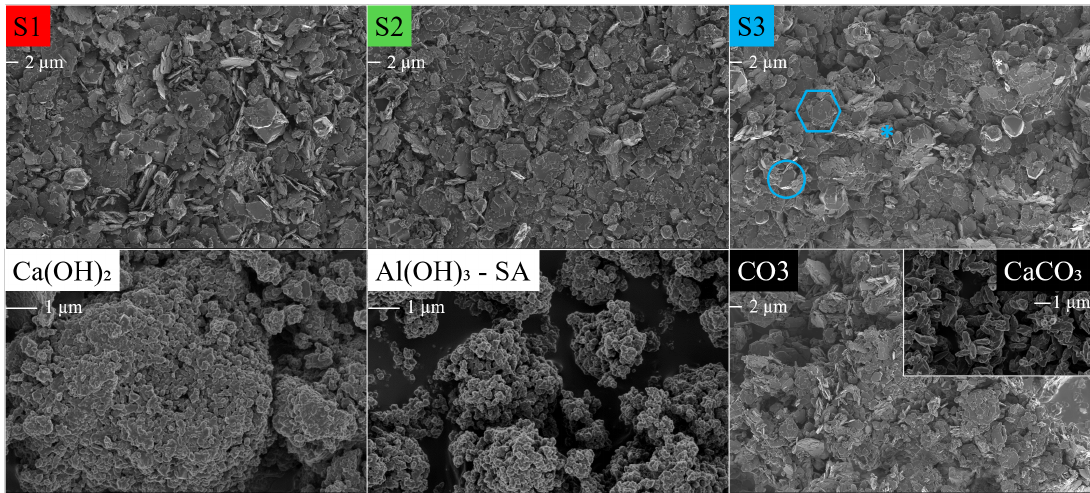
Figure 3. SEM micrographs of the HC LDHs S1, S2, S3 and CO3 at 1keV and 2k magnification, and Ca(OH) 2 , Al(OH) 3 -SA (amorphous) and CaCO 3 at 1kEV and 10k magnification. The scale bar is indicated under the label. LDH: turquoise hexagon, katoite: turquoise circle, calcite: turquoise asterisk.